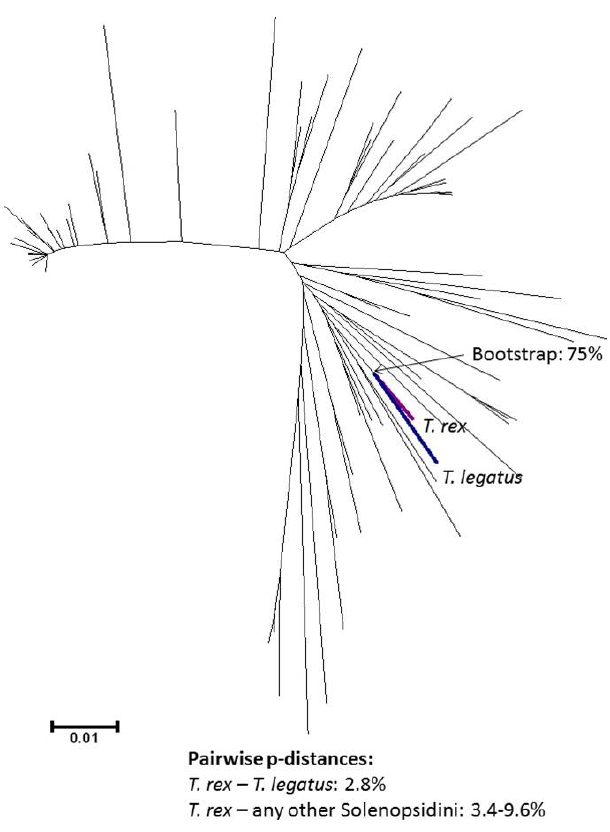
Fig 3 . Unrooted neighbor-joining tree based on pairwise p-distances among all Solenopsidini wingless sequences available in